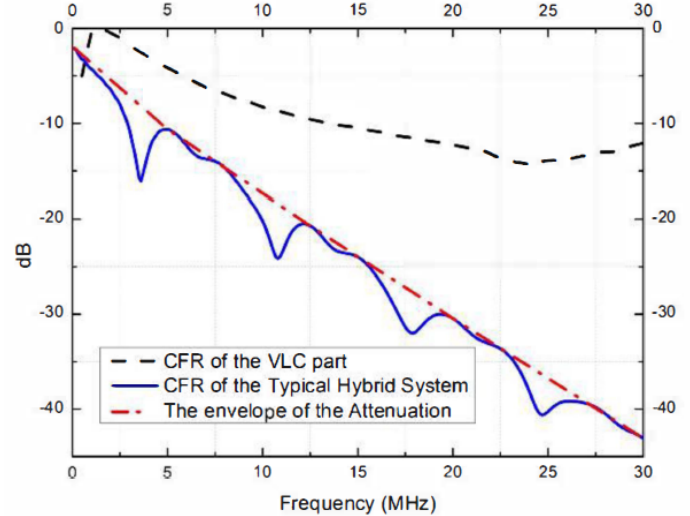
Figure 7. The measured channel frequency response (CFR) of a typical integrated PLC and IWOC system [19].